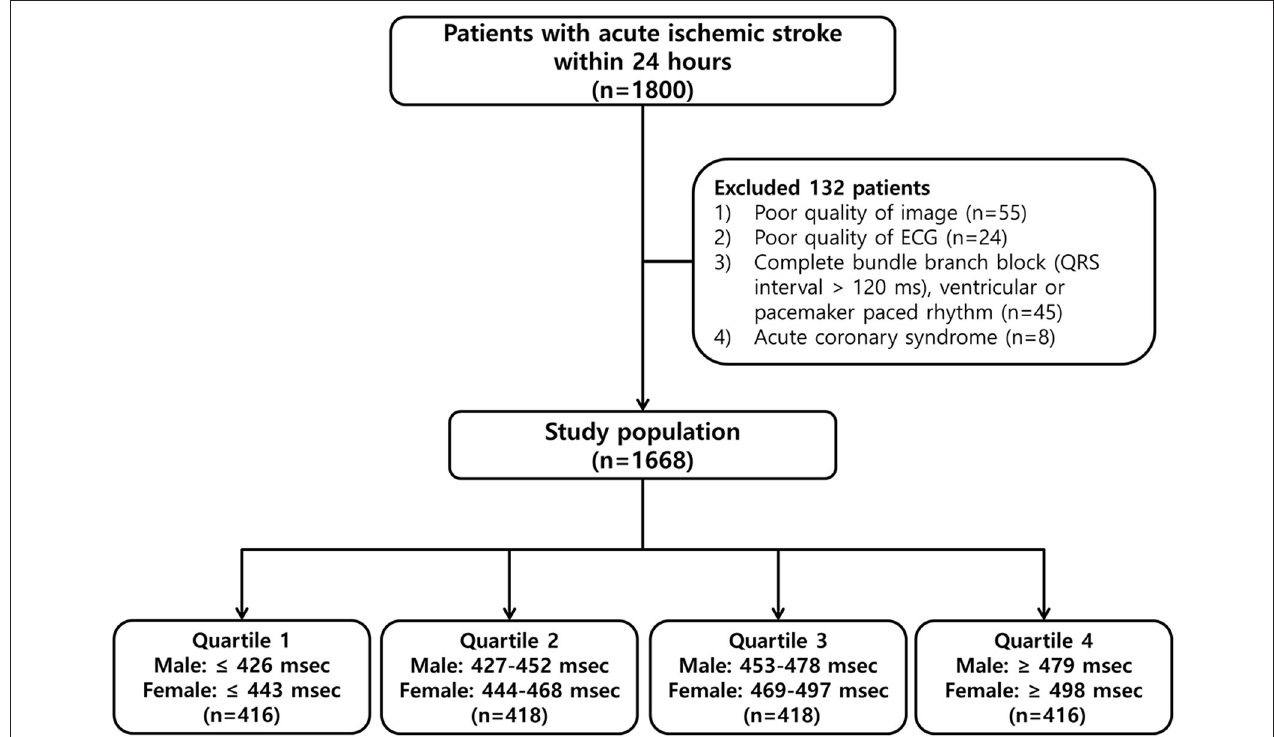
FIGURE 1 | Flowchart of the patient selection process and classification by quartiles of the corrected QT (QTc) interval.